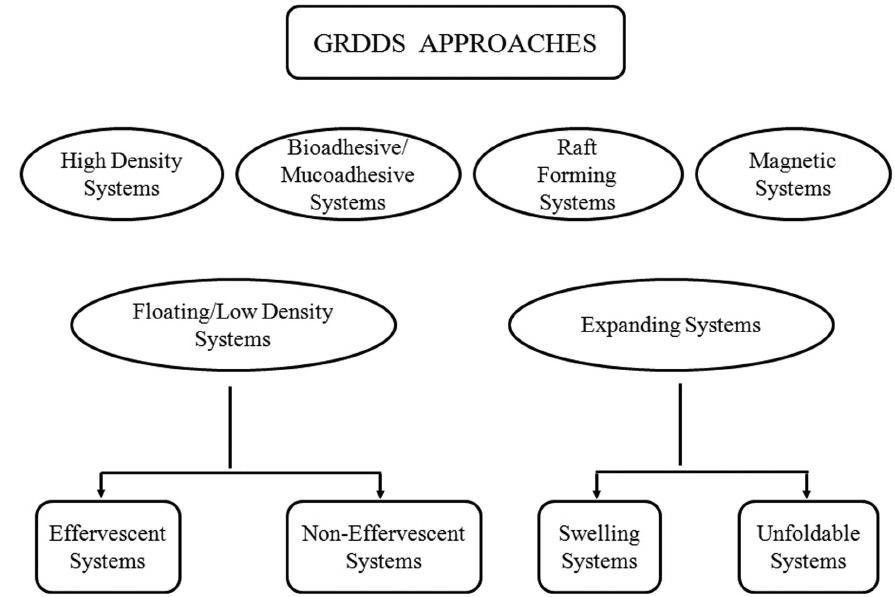
FIGURE 1 - General approaches to gastric